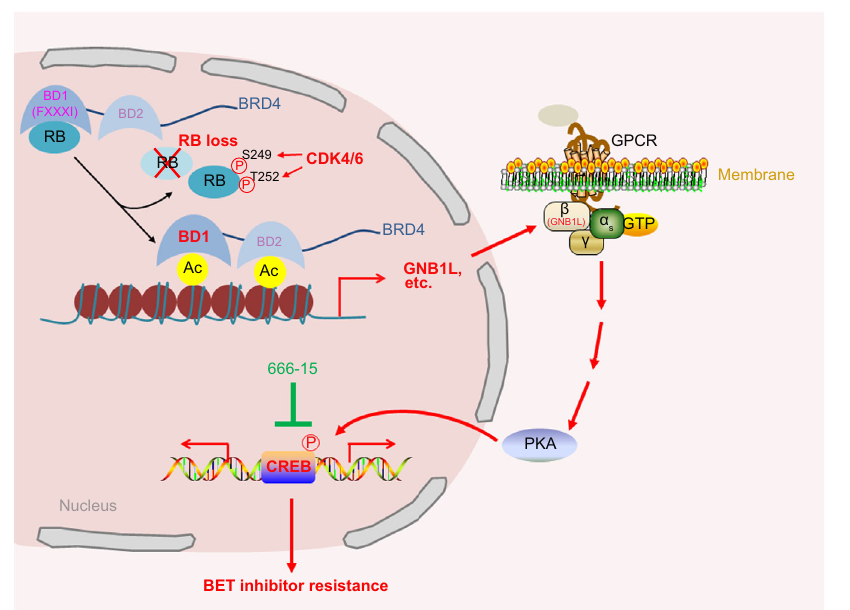
Fig.7|TheschemadepictingtheBETinhibitorresistanceinPCacellsduetoRB lossand hyperphosphorylation. RBbindsto the BD1ofBRD4and impedesBRD4 targeting of chromatin. However, RB loss or phosphorylation by CDKs such as CDK4/6augmentsBRD4occupancy on chromatin atgenomiclocisuchasgenesin